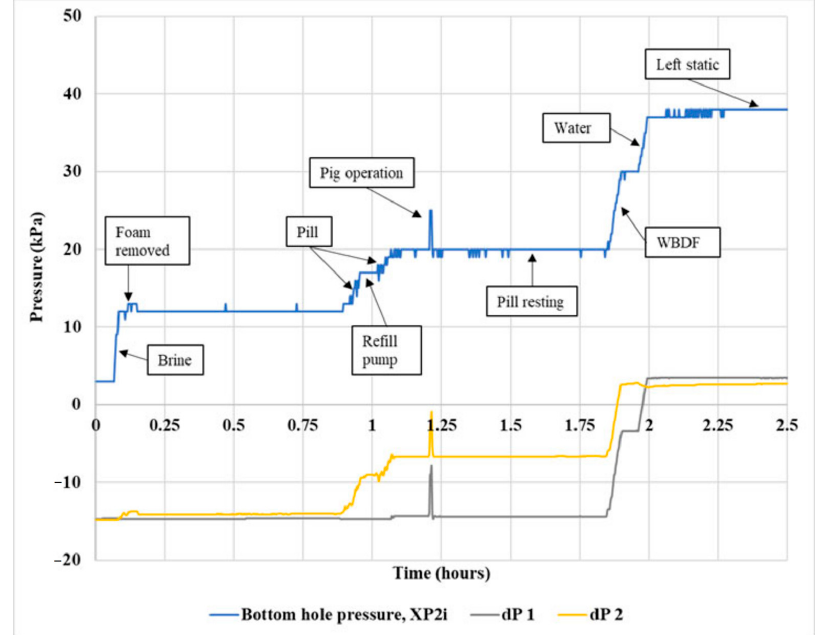
Figure 8. Recorded pressure during placement of fluid volumes. The bottom hole pressure is shown as the blue line. The differential pressures dP1 and dP2 are shown as the orange and gray lines, respectively. The zero pressure is valid for the bottom hole pressure only (blue curve). For the dP-sensors, the zero level is